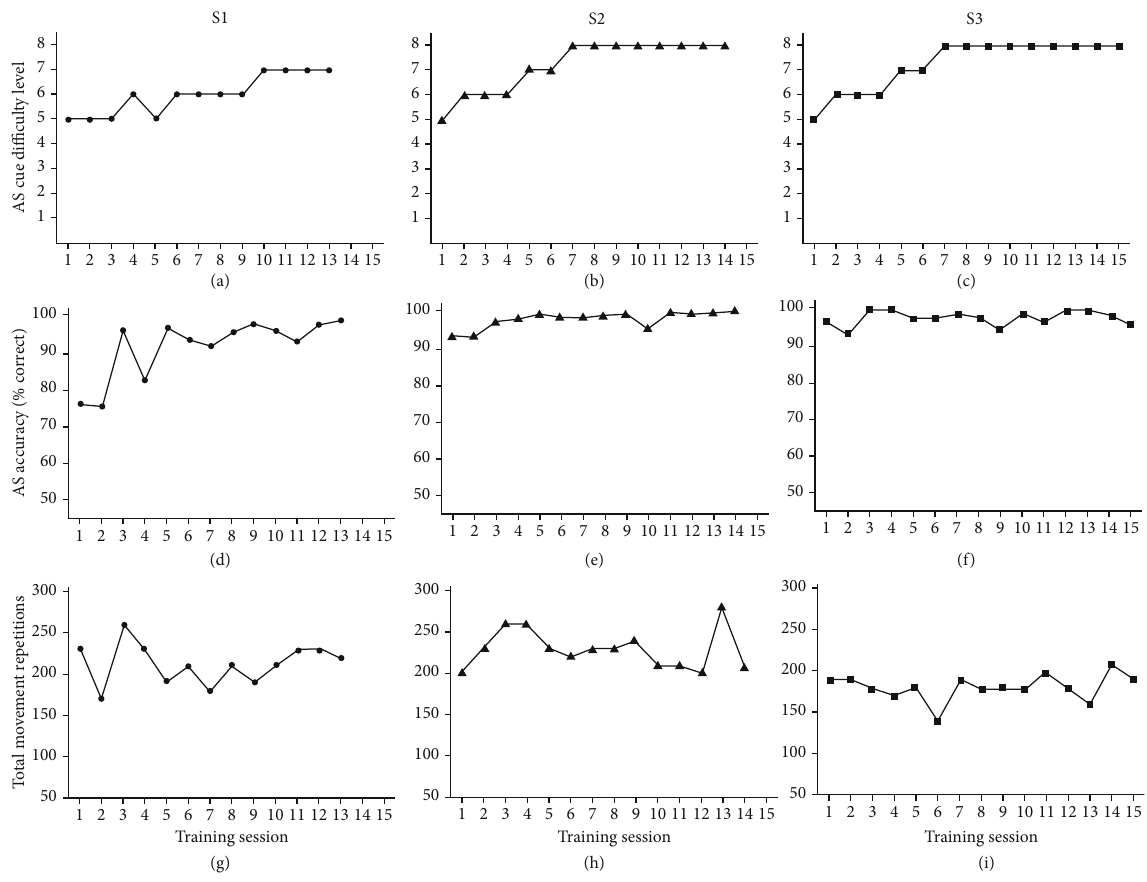
Figure 3: Training data by session and participant including action selection (AS) cue di ffi culty level (a – c), AS accuracy (d – f), and total number of movement repetitions (g – i).